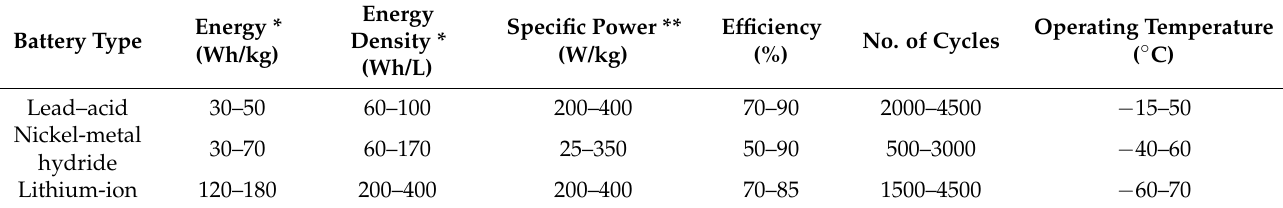
Table 2. Typical characteristics of EV batteries